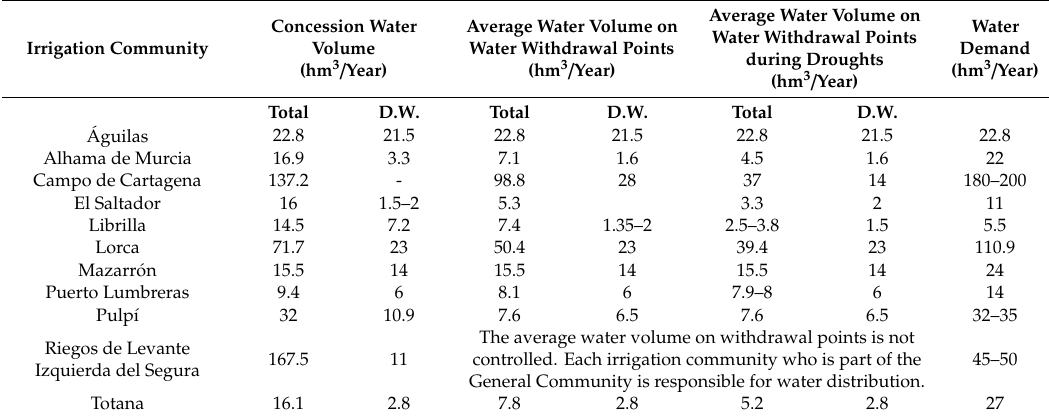
Table 3. Concessional water volume, average water volume on irrigation tapping point during an average hydrological year and a drought situation, and total water demand by irrigation community.